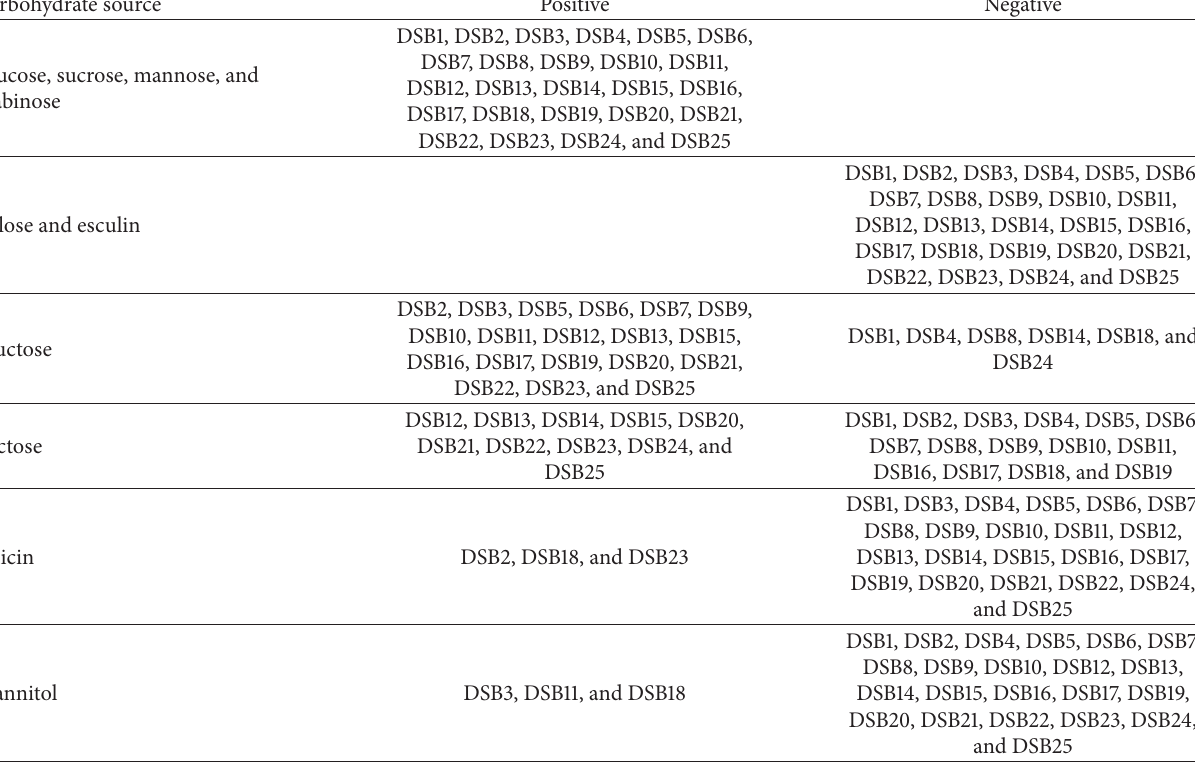
Table 4: Fermentation tests of the Bacillus spp. isolated from the coastal areas of Digha, West Bengal, India. Carbohydrate source